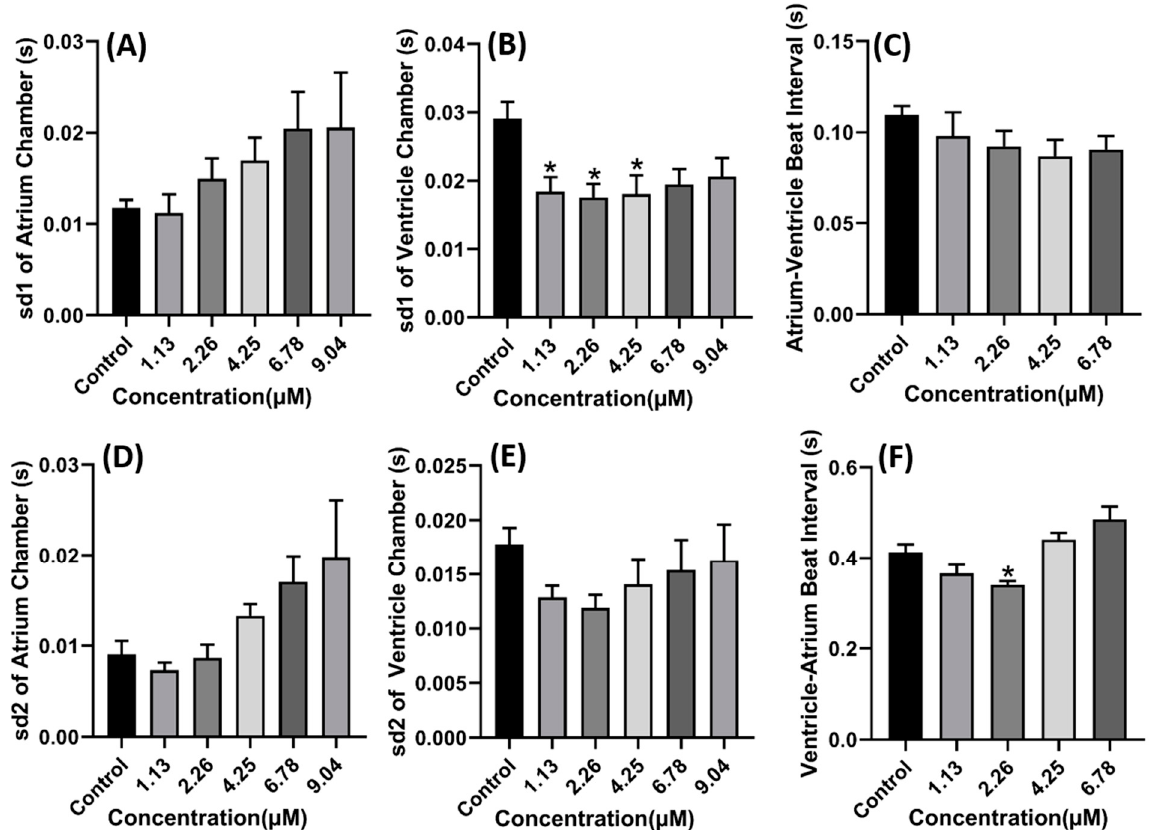
Figure 6. Cardiac rhythm alteration induced by carbofuran in zebrafish larvae. ( A ) Atrium SD1. ( B ) Ventricle SD1. ( C ) Atrium–ventricle interval. ( D ) Atrium SD2. ( E ) Ventricle SD2. ( F ) Ventricle–atrium interval. Data were statistically analyzed using a Brown–Fosythe one-way ANOVA with a Dunnett post-hoc test for multiple comparisons. * p < 0.05.